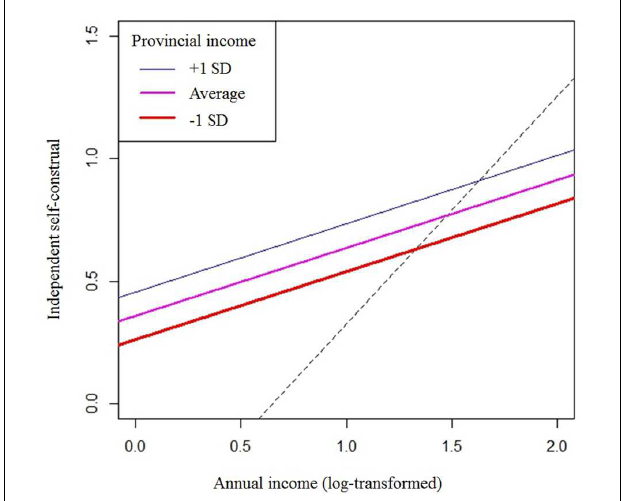
FIGURE 1 | Results of the multilevel analysis: Independent self-construal as a function of logged annual household income. In the graph, the three solid lines are regression lines for the effect of individual-level income on independent self-construal at three levels of provincial income (average household income at the province level). The dotted line is the regression line for the relationship between province-level income and independent